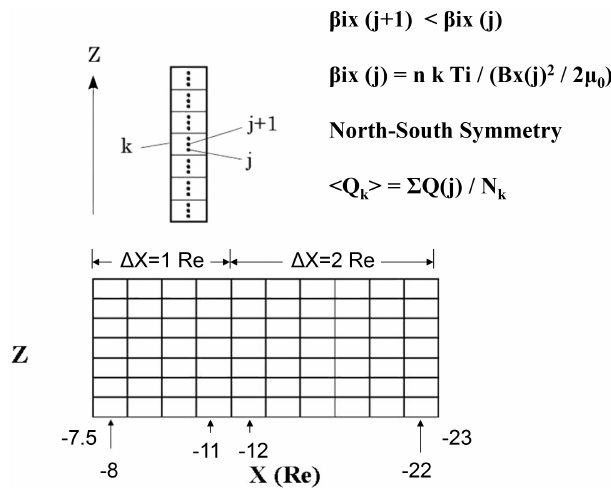
Fig. 1. Schematic illustration of our method of obtaining structures in the meridional ( X – Z)